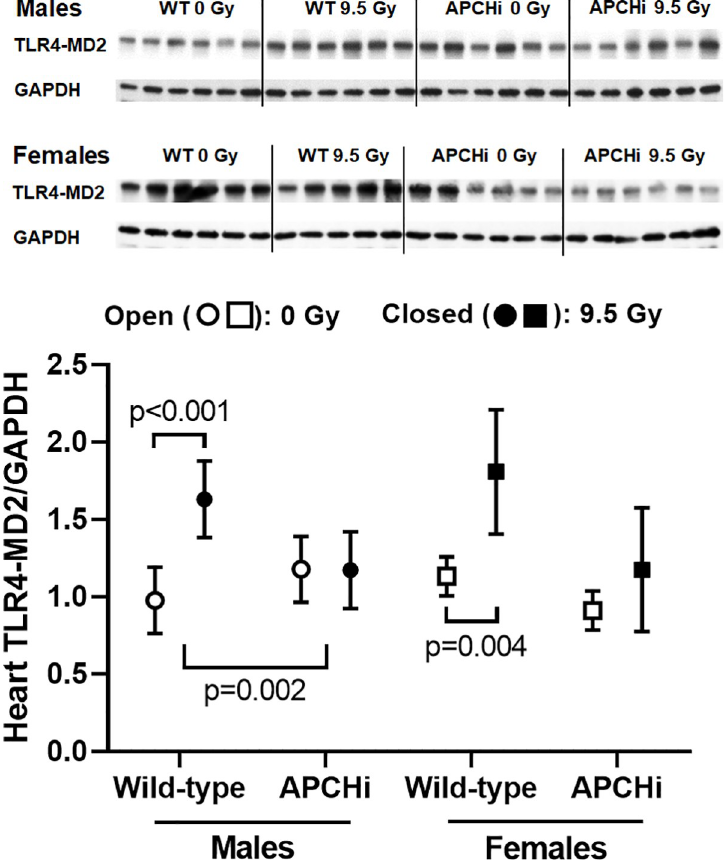
Fig 3. Left ventricular expression of TLR4 at 6 months after irradiation. Immunoblotting was used to assess left ventricular levels of TLR4 corrected by loading control GAPDH. Graphs indicate means and SD of the statistical model; n = 6 mice per group. Short brackets indicate significant differences between 0 Gy and 9.5 Gy. The wider bracket indicates that the effect of radiation in wild-type mice is significantly different from the effect of radiation in APCHi